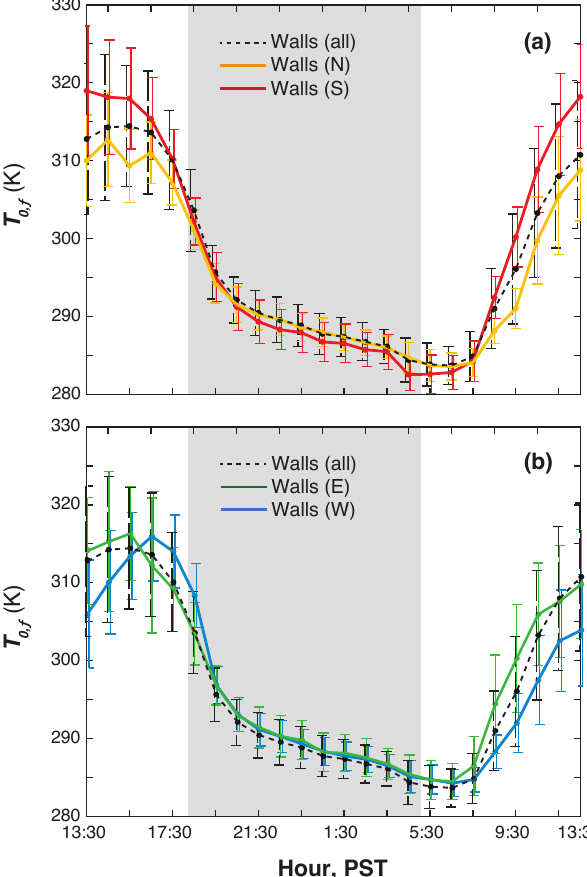
Figure 6. Area-weighted wall temperatures divided by facet orien- tation. Error bars show 1 standard deviation. (a) North- and south- facing walls. (b) East- and west-facing